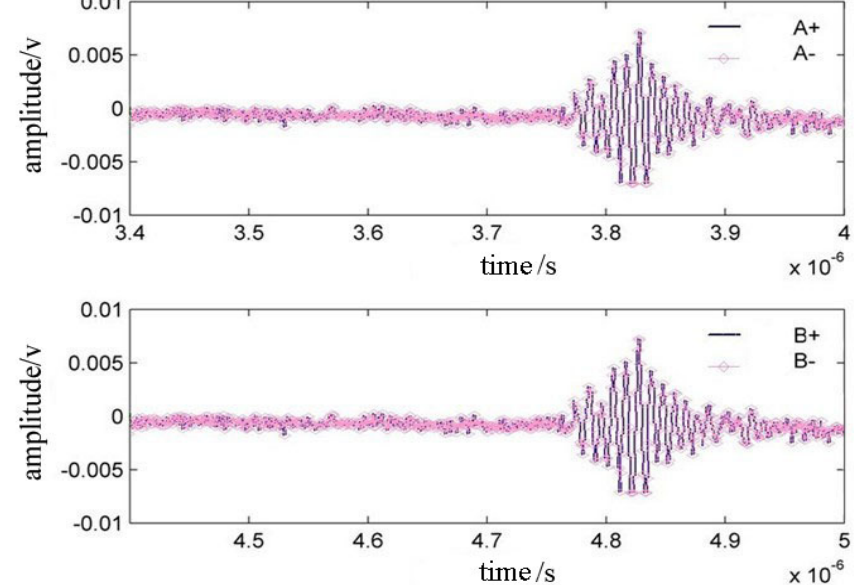
Figure 7. Overlapped waveforms in time domain when the detecting line coincides with the propagating